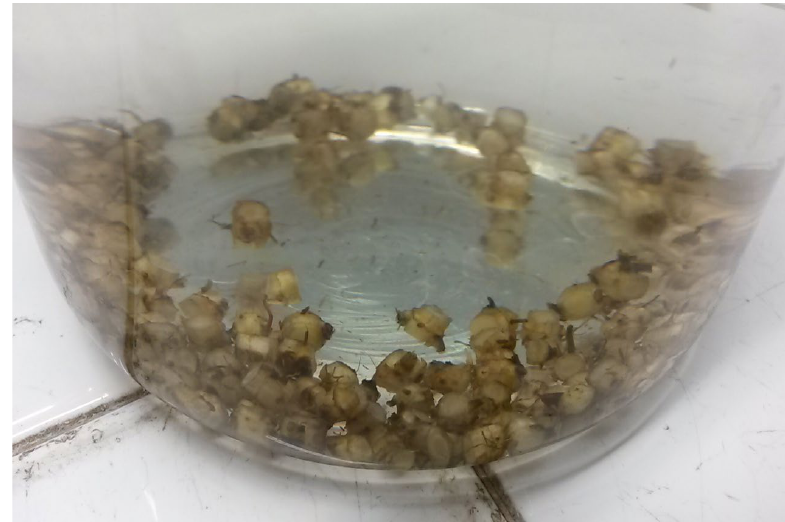
Figure 2. Isolated nodes of stolon during the surface sterilization.